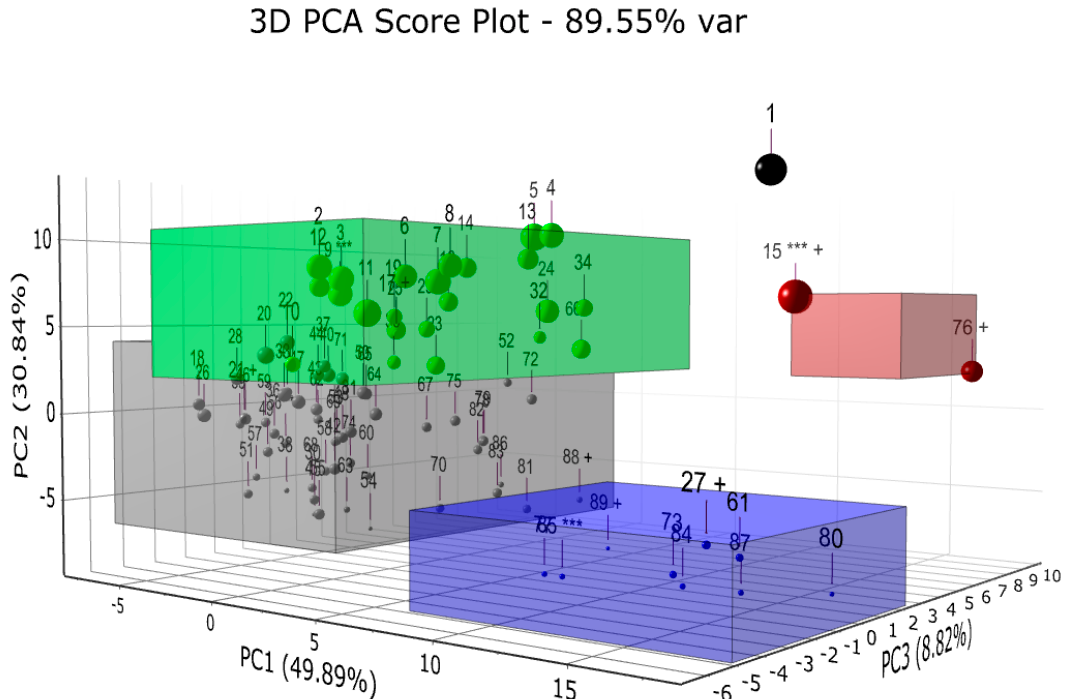
Figure 9. Principal Components Analysis plot of XRD scans of copper concentrates. Each scan is represented by a sphere with a radius proportional to its pyrite content. The four clusters and the one outlier are visualized in different colors. *** representative XRD scan of each cluster, + most different XRD scans within a